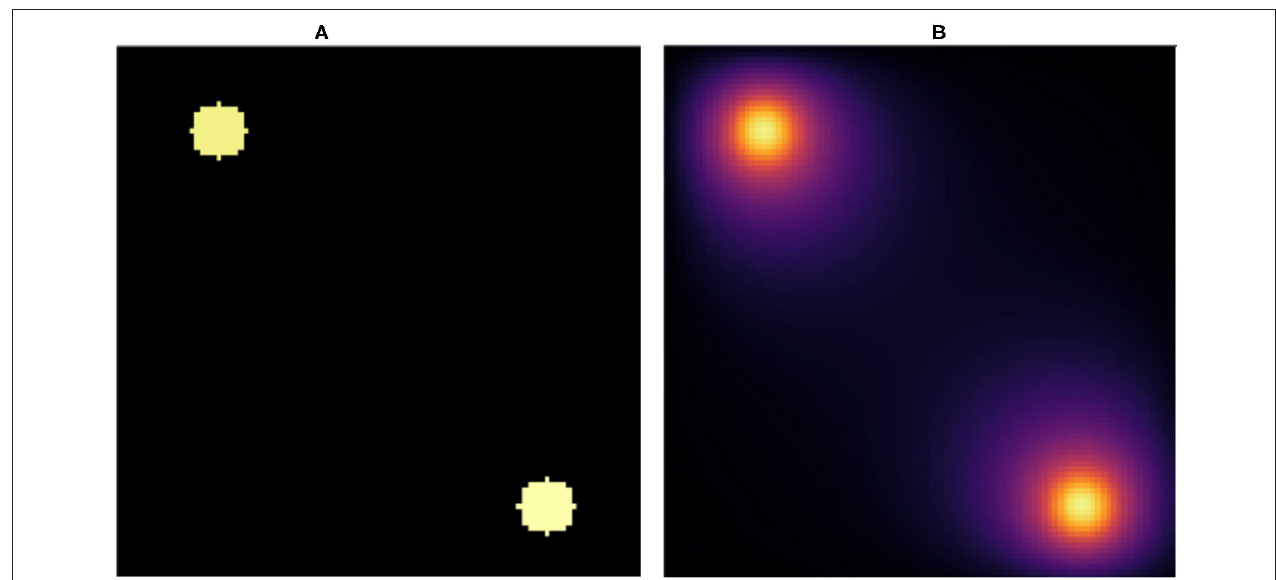
FIGURE 1 | Snapshot of (A) initial condition and (B) stationary state solution. (A) We placed two random value sources of radius 5 voxels in random positions fully within a 100 100 pixel lattice and used this configuration as the input to the NN. (B) Stationary solution to the diffusion equation with absorbing boundary conditions × for the initial conditions in (A) . The stationary solution (B) is the target for the NN. We fixed the diffusion constant to D γ 1 / 400 s − 1 , which yields a diffusion length equal to p D /γ voxels =